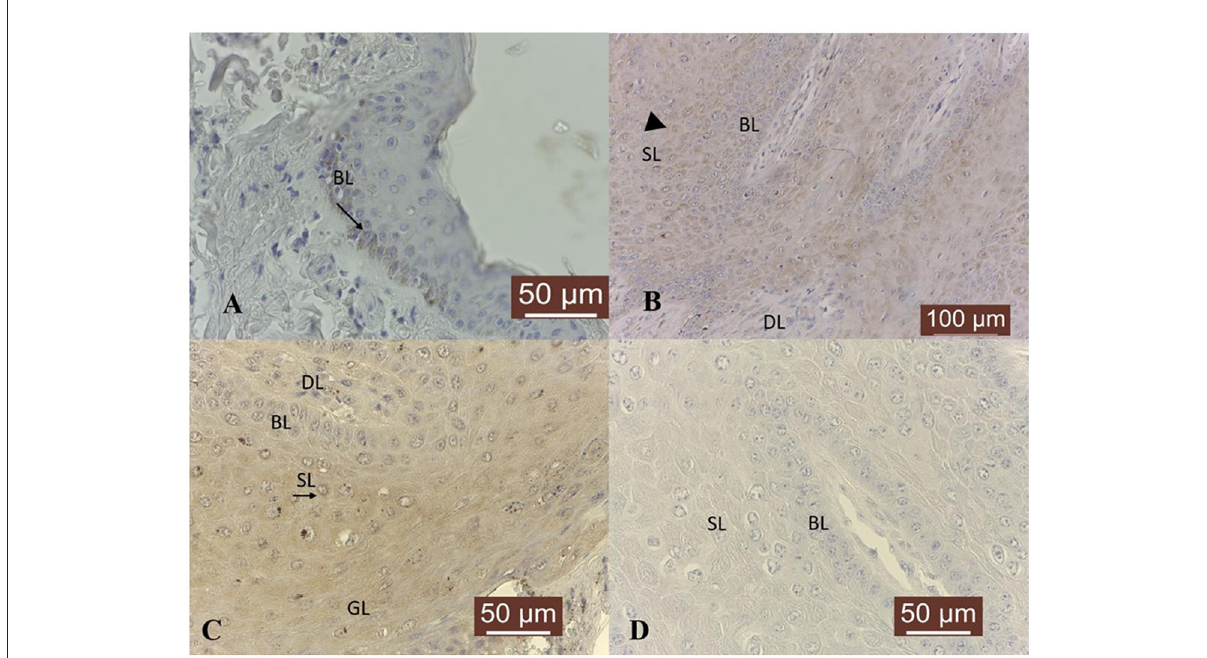
FIGURE6 TIMP-1 immunoexpression in bovine normal skin and fibropapillomas: (A) TIMP-1 is detected as a moderate cytoplasm (black arrow) pattern in normal skin basal cell layer (BL); 40 X. (B) In tumor samples, TIMP-1 expression was recorded as a weak finely granular staining pattern in the cytoplasm of keratinocytes from basal (BL), spinosum (SL) (black arrowhead) and granular (GL) layers, while few fibroblasts from dermal layer (DL) showed a weak immunoreactivity; 20 X. (C) Note a moderate granular cytoplasmic pattern (black arrow) in spinosum layer of tumor; 40 X. (D) Negative control: fibropapilloma with the first antibody anti-TIMP-1 omitted and incubated with secondary antibody did not stain; 40